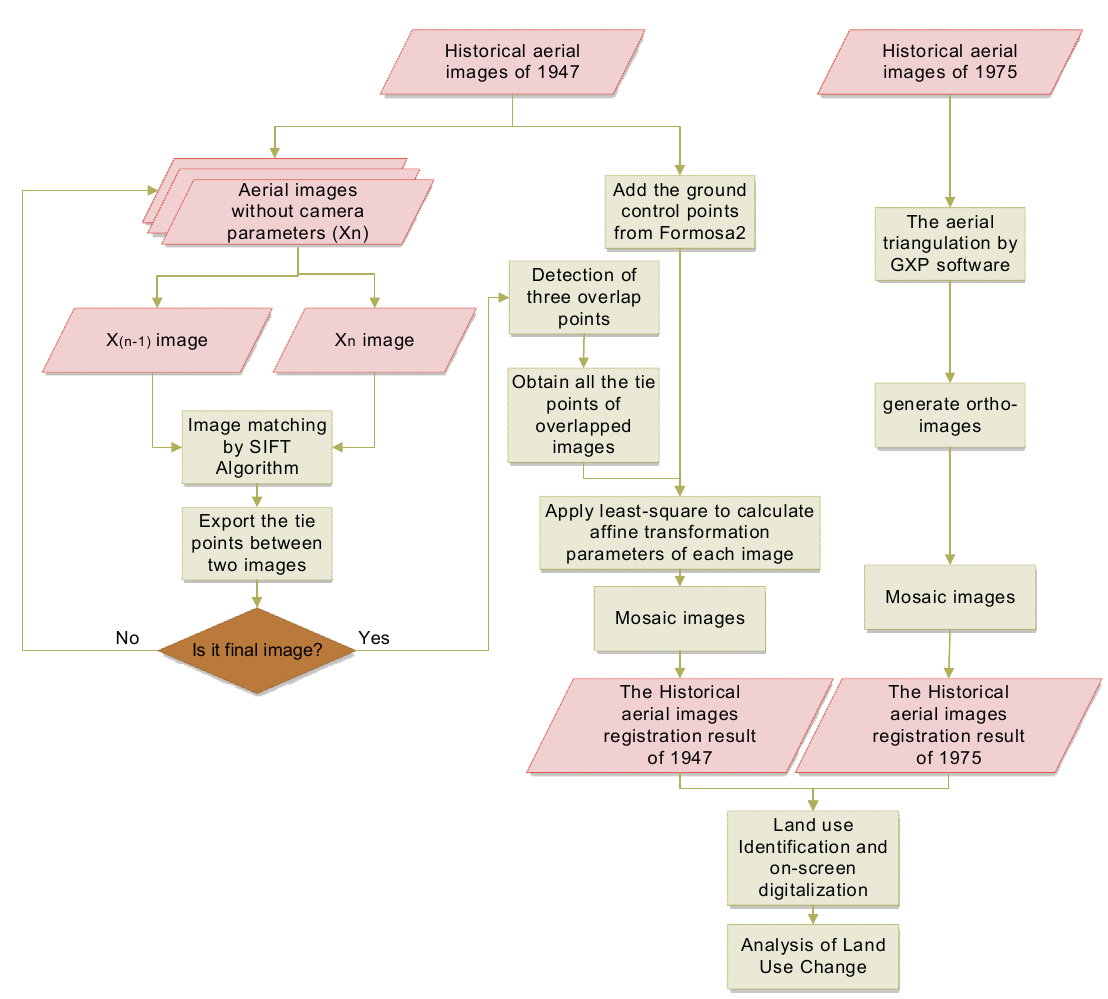
Figure 2. Workflow of this